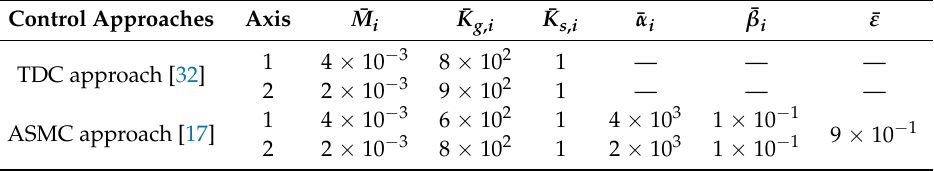
Table A2. Parameters of control approaches for